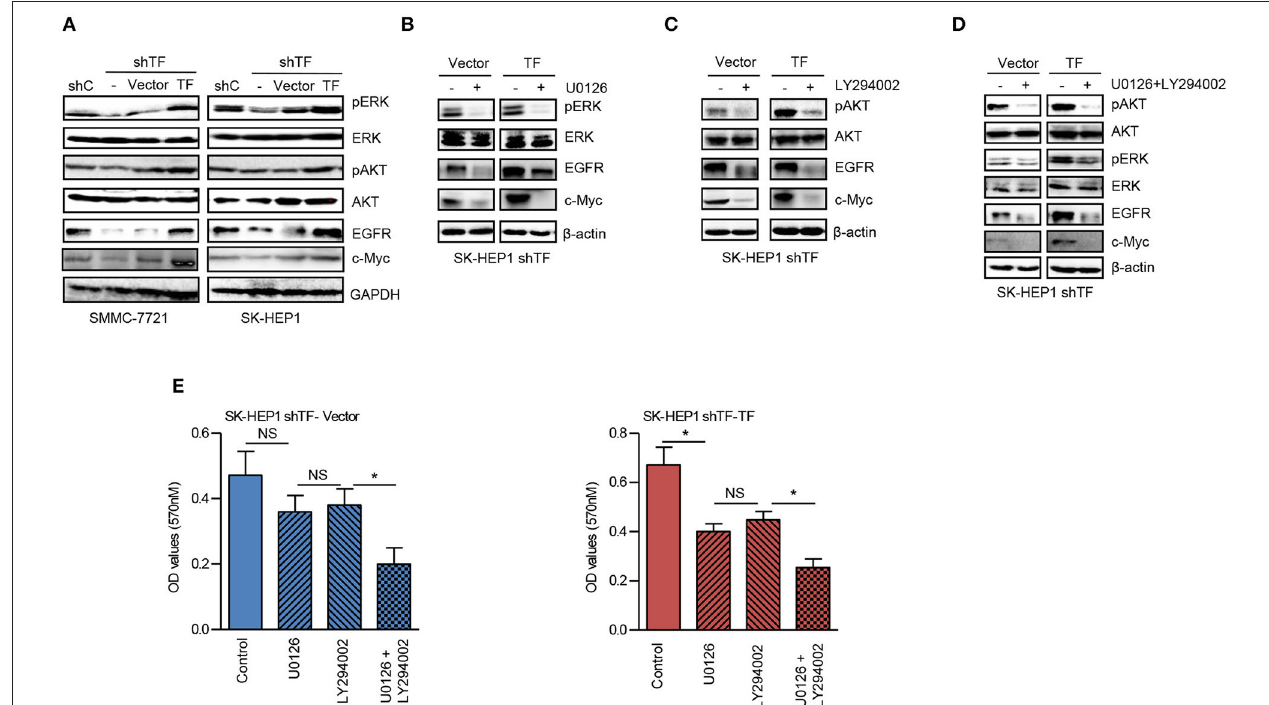
FIGURE 3 | TF promotes the growth of HCC by activating both ERK and AKT signaling pathways. (A) Western blot analysis of the protein expressions in the indicated cells. SK-HEP1 shTF-Vector and SK-HEP1 shTF-TF cells were treated with/without U0126 and LY294002 at the concentration of 10 µ M for 24h. (B–D) Western blot and (E) MTT assay analysis of the protein expressions and cell growth. Error bars, mean ± SD. * p < 0.05 (two-tailed Student’s t -test E ).